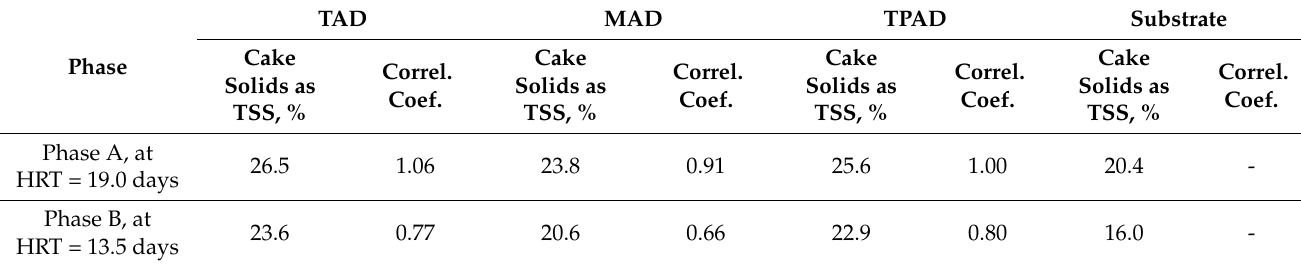
Table 10. Sludge cake solids prediction for the digestate after AD and its correlation with mechanical pressing results.